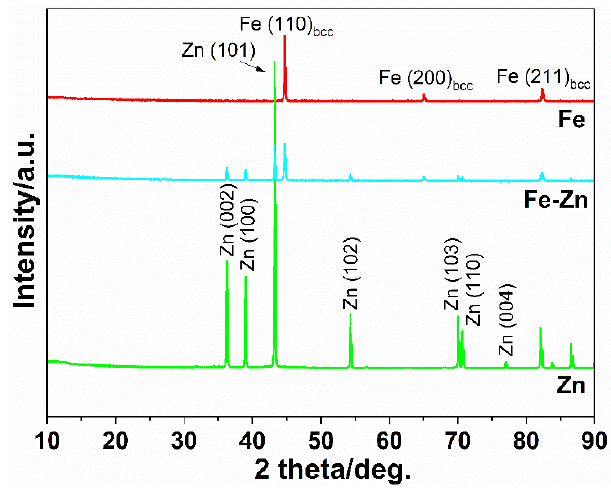
Figure 4. XRD spectrum of Zn, Fe and Fe-Zn compressed metallic powders.